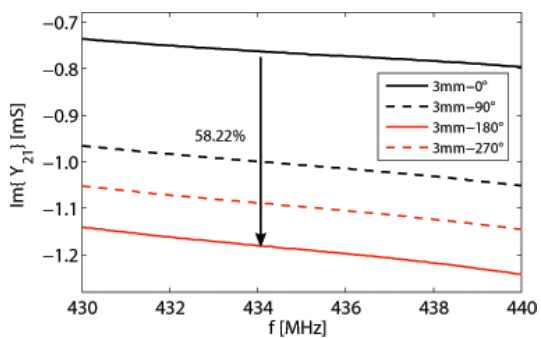
Figure 12. Measured angular of transmission susceptance Im( Y 21 ) in extended ISM frequency range for a 3mm gap.